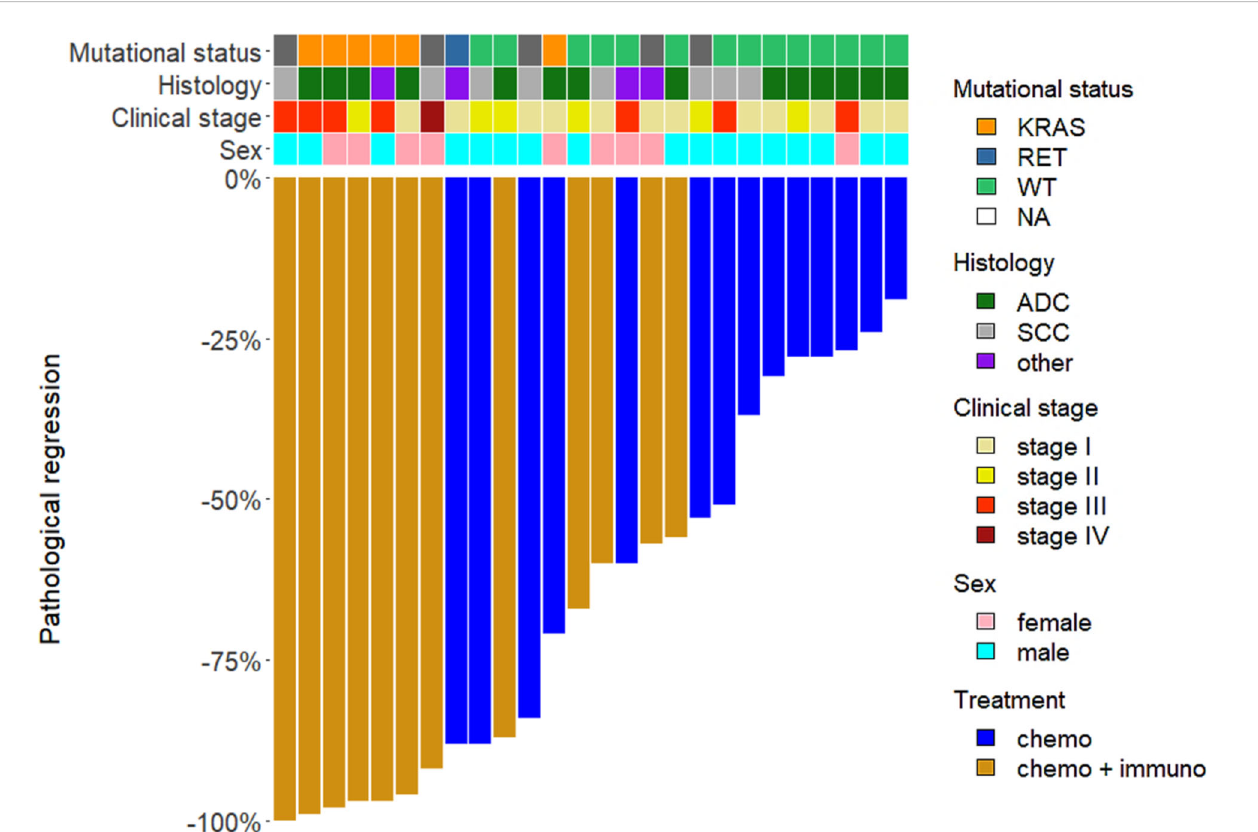
FIGURE 2 Waterfall plot of pathological response. The bars represent patients according to the different neoadjuvant treatments, chemotherapy alone (chemo) and chemo-immunotherapy (chemo-immuno). The upper rows show clinic-pathological characteristics of patients (mutational status, histology, clinical stage, sex). WT, wild-type; NA, not available; ADC, adenocarcinoma; SCC, squamous cell